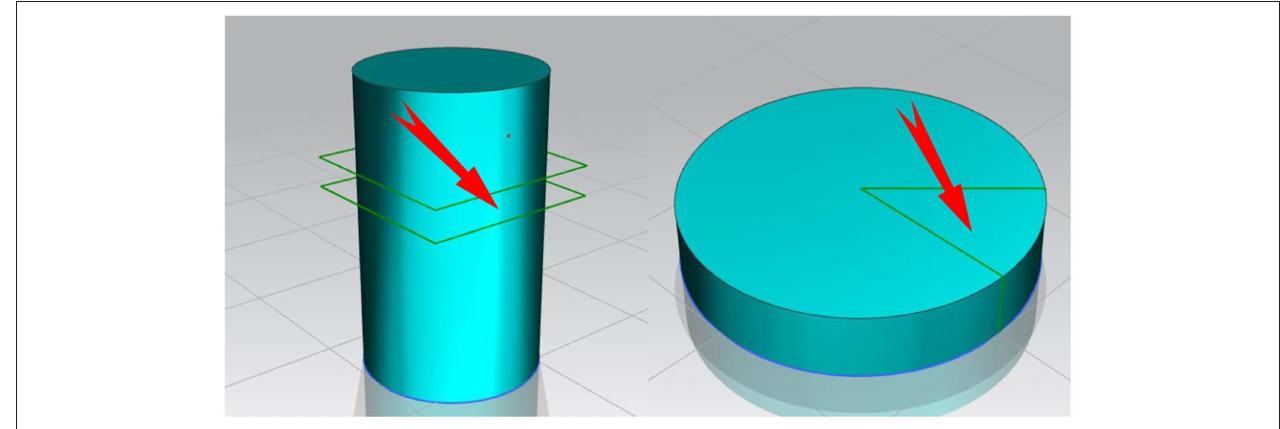
FIGURE 1 | The selected position of samples for microstructures